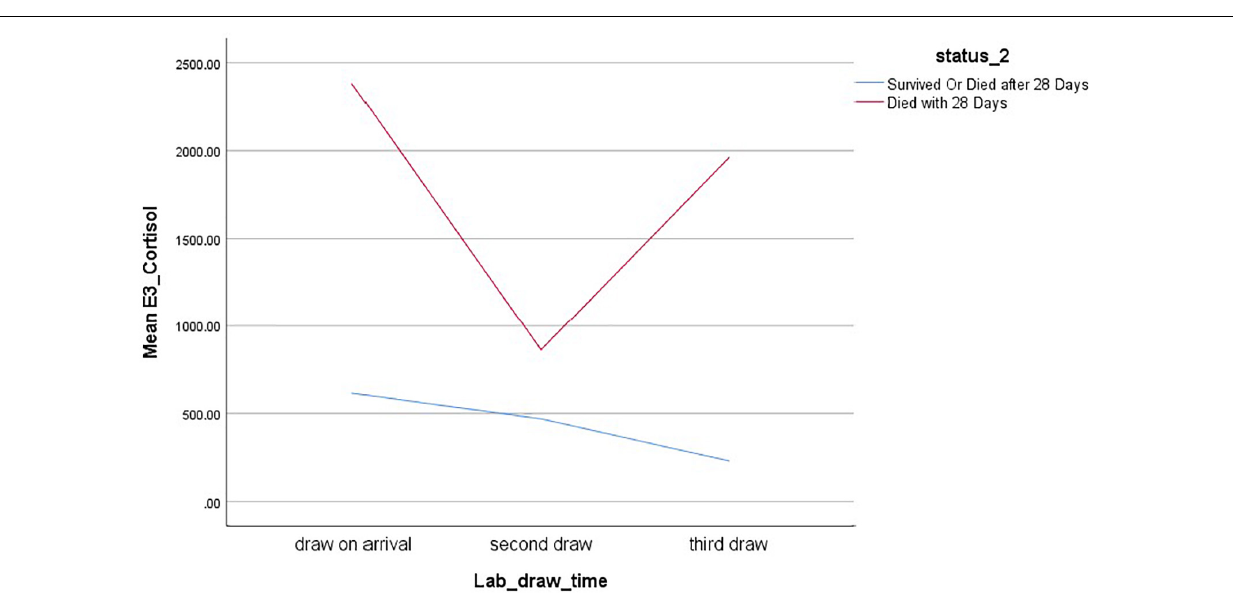
Frontiers in Medicine |